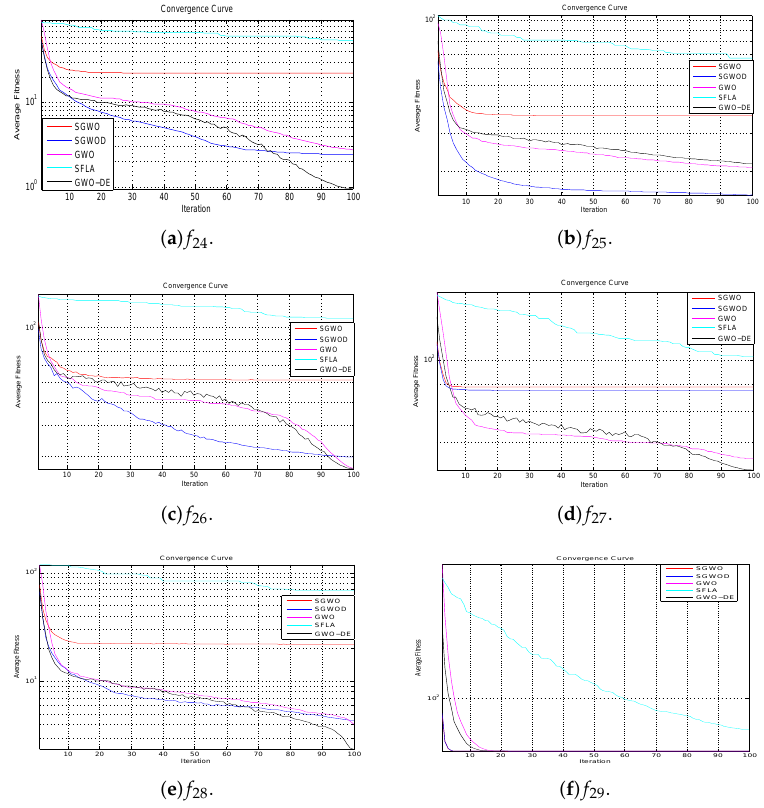
Figure 9. Convergence curves of composite multimodal benchmark